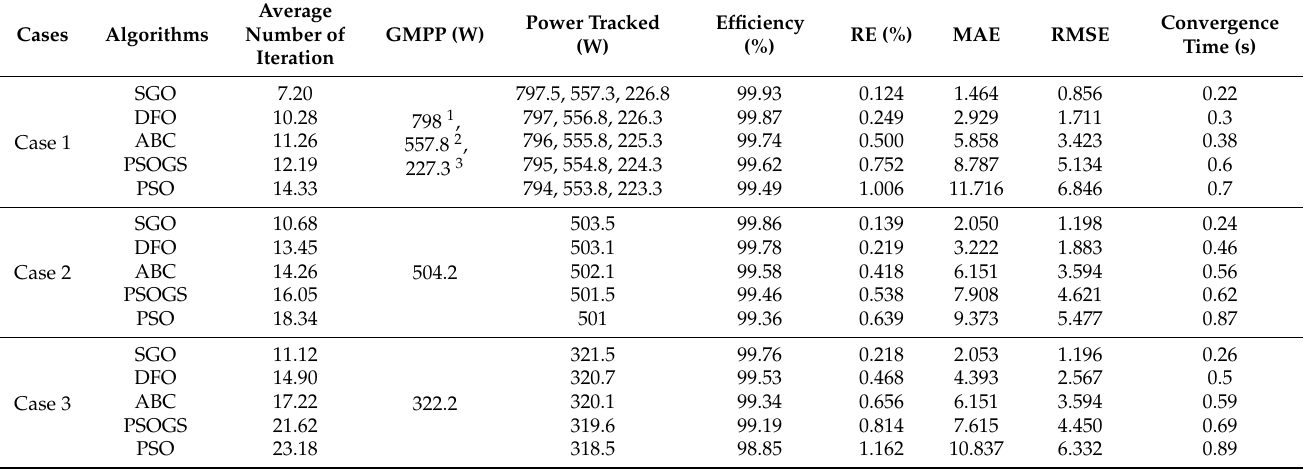
Table 4. Statistical analysis